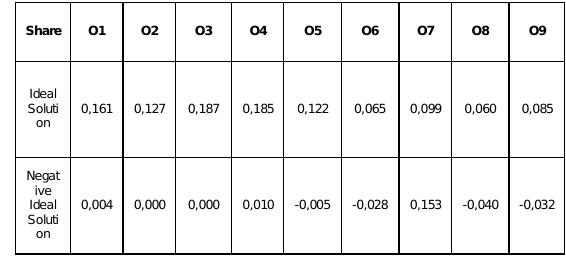
Table 11: Ideal (A+) and Negative Ideal (A) Solution Table For Year 2013